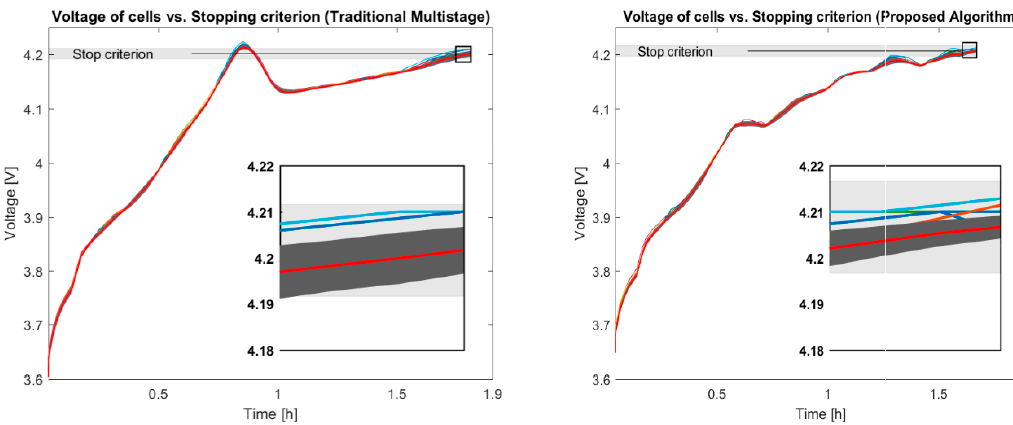
Figure 22. Voltage profile per cell vs. stopping criterion considering the traditional multistage method and the proposed method. The red line represents mean voltage, the gray area represents the mean of the voltages ± the standard deviation.